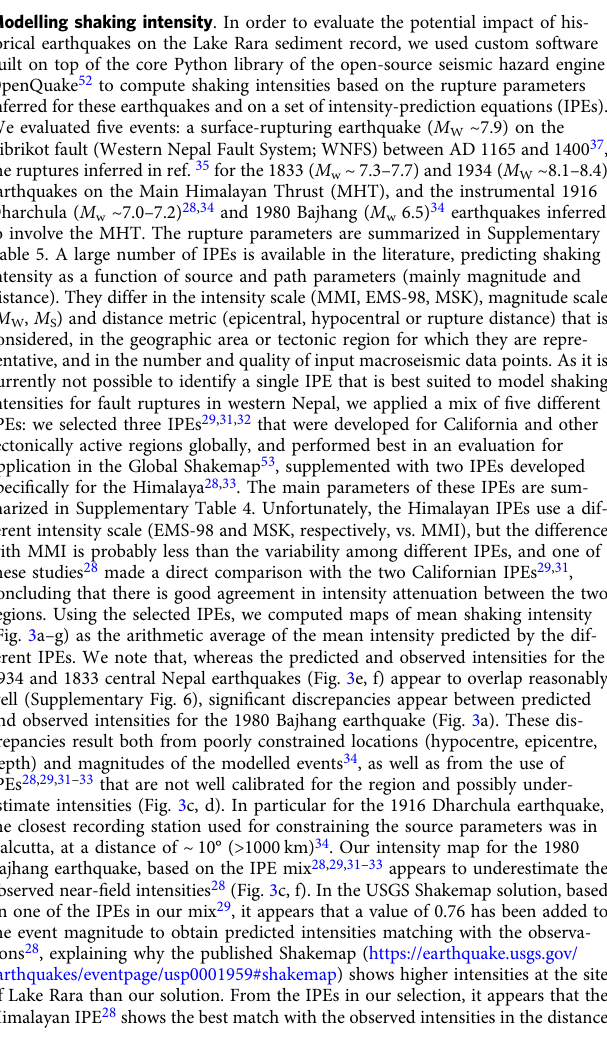
(Supplementary Table 1) and radionuclide ( 210 Pb and 137 Cs; Supplementary Tables 2, 3) dating. Samples for radiocarbon dating were picked outside of the turbidites, as these are considered to be instantaneous deposits. Radionuclides 210 Pb and 137 Cs were measured respectively on 11 and 9 bulk- sediment samples from core RA14-SC05 (Supplementary Fig. 4) by Flett Research Ltd. (Winnipeg, Canada) following the methods of refs. 46,47 . Radiocarbon ages for cores RA14-SC05 and RA14-SC06 were obtained by dating four and fi ve leaf samples, respectively. After acid-alkali-acid pre-treatment, the samples